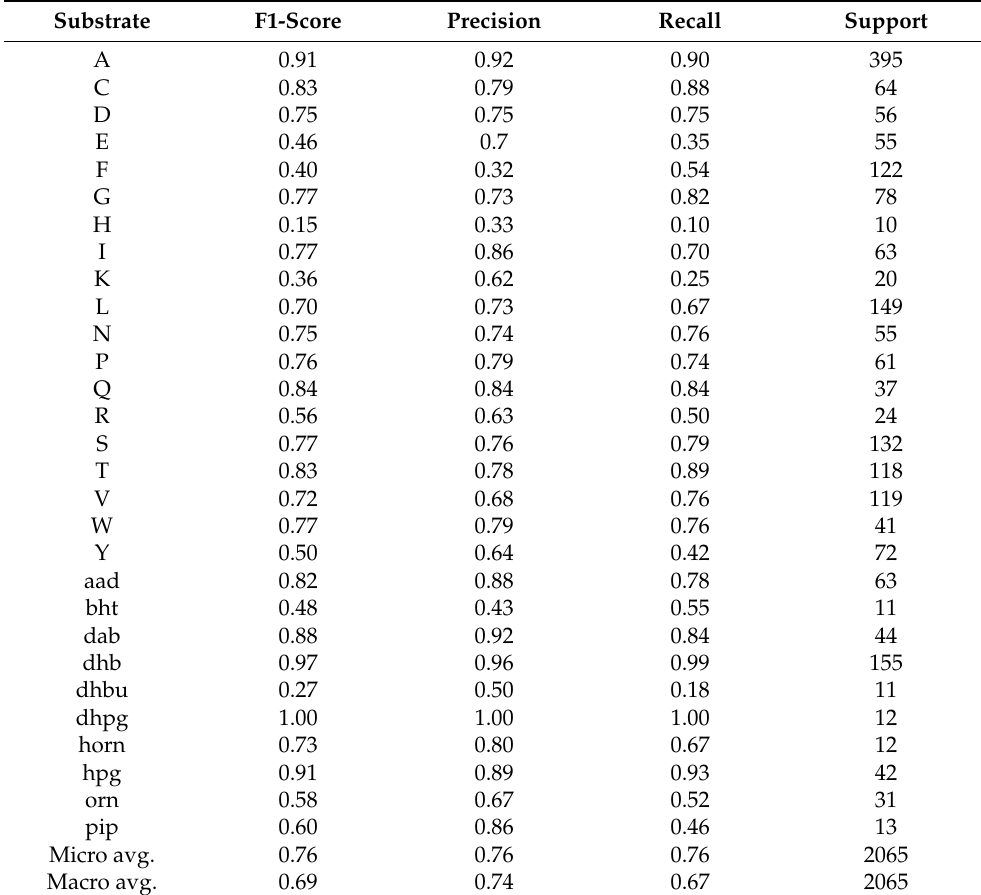
Table 5. Performance for each substrate for A-domain classification. The amino acids are named according to the standard amino acid one-letter code. Special substrate abbreviations are: